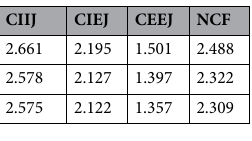
Table 2. Comparison of similarity between different combinations of Brassica rapa reconstructed